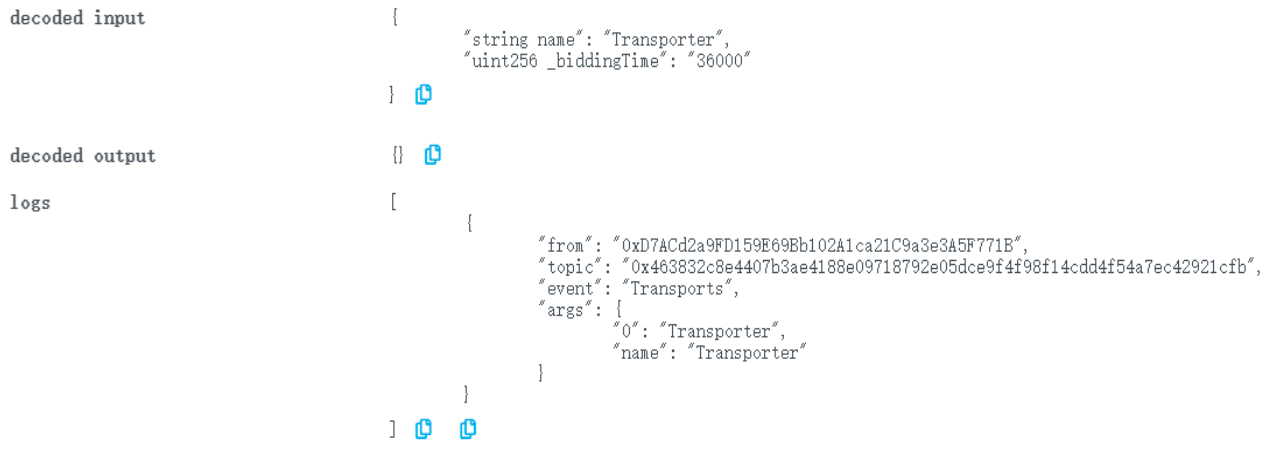
Figure 6. Logistics information encryption on the chain. Table 2. Functional comparison of e-commerce